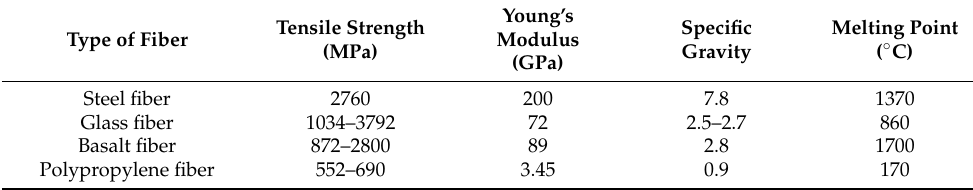
Table 3. Physical properties of SF, GF, BF, and PP